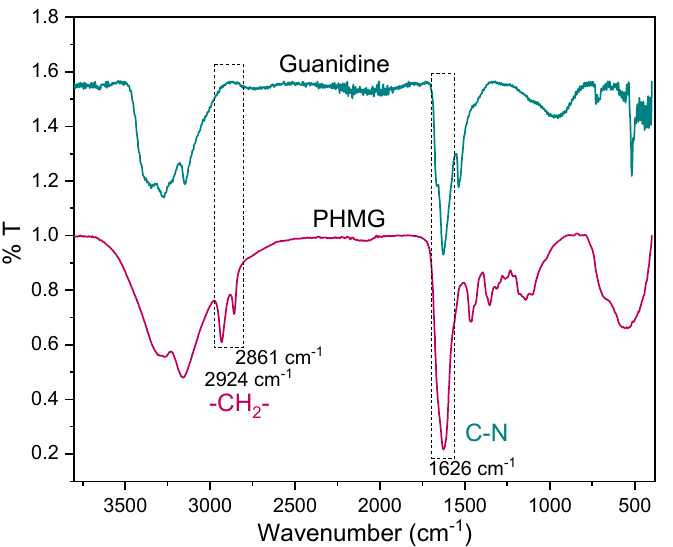
Figure 2. ATR-FTIR spectra of guanidine and the PHMG oligomer obtained after polycondensation.